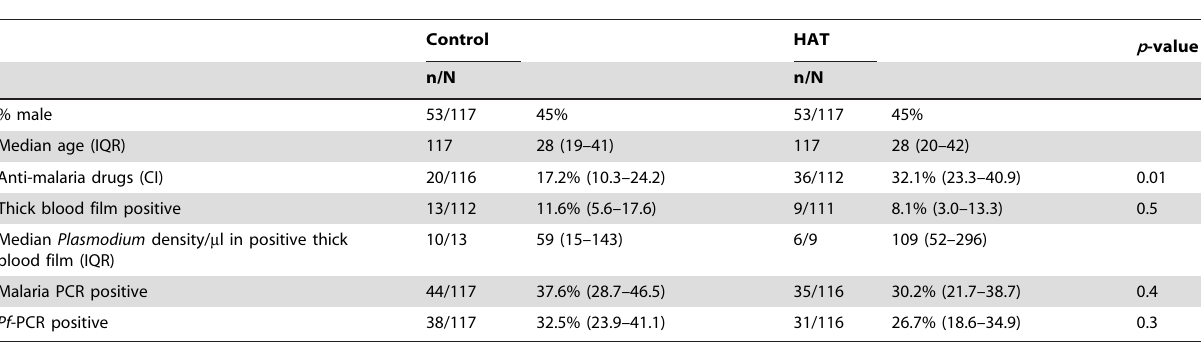
Table 1. Study population and reference test results.